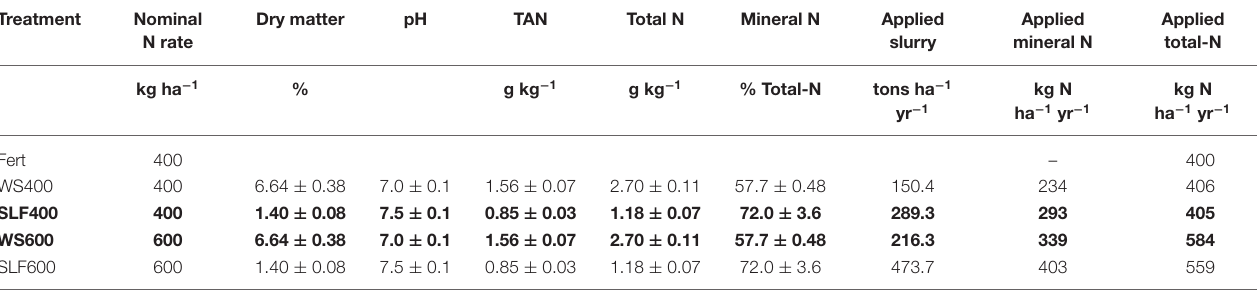
TABLE 2 | Mean composition ( ± SD) and annual rates of whole dairy slurry (WS) and separated liquid fraction (SLF) and ammonium nitrate fertilizer (FERT) applied in four equal doses. Treatment